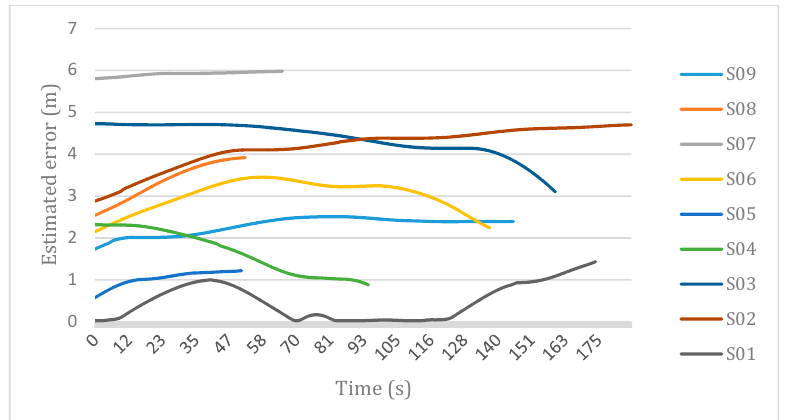
Figure 22. Estimated GPS error by MMS-K320 for each of the nine surveys.